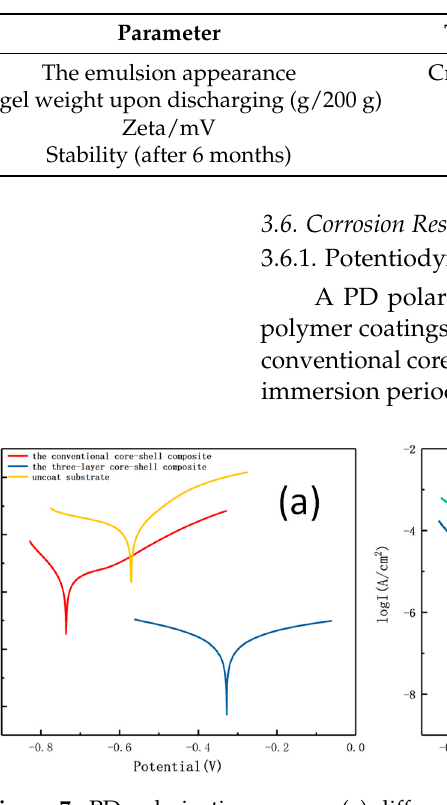
Figure 7. PD polarization curves: ( a ) different samples at the initial immersion, ( b ) curves of conventional core-shell structure at different immersion time intervals, and ( c ) three-layer core-shell structure at different immersion time intervals.